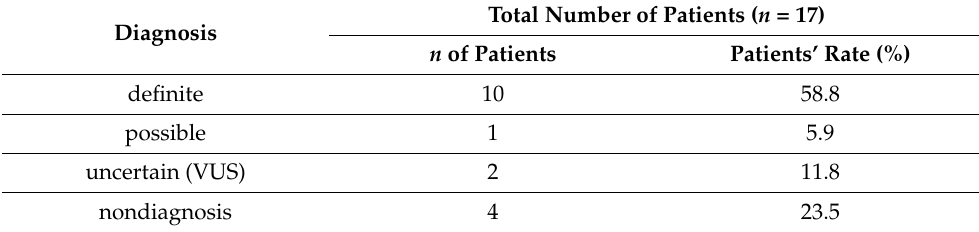
Table 3. The overall molecular diagnosis rate.